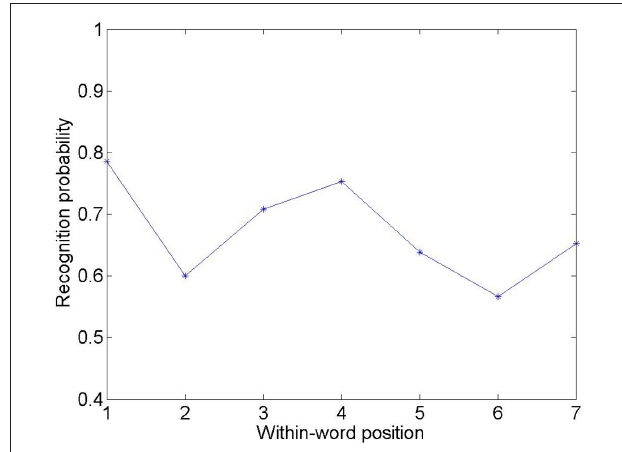
Figure 2 | Letter visibility (recognition probability) as a function of within-string position, for a seven-letter string with fixation on the central position (i.e., the fourth letter) from Stevens and grainger, 2003. Note that this recognition curve is based on data collected in